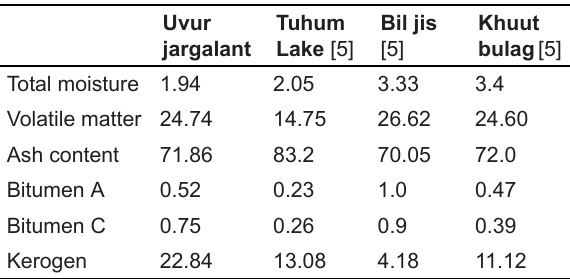
Table 1. Proximate analysis and composition of bitumens of Mongolian oil shale (wt %)